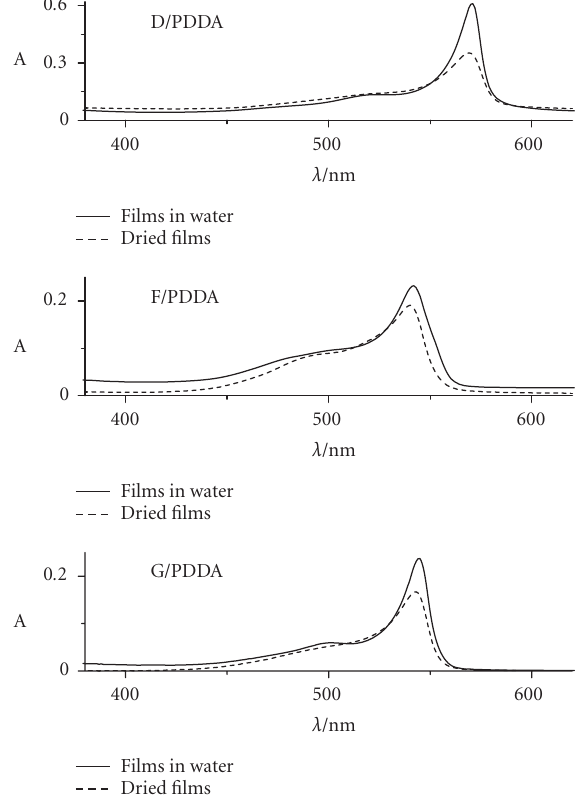
Figure 3: Absorption spectra of ESAMs (5 bilayers) of cyanines D, F, and G with PDDA. Films in water (solid lines); dried films (dashed lines).